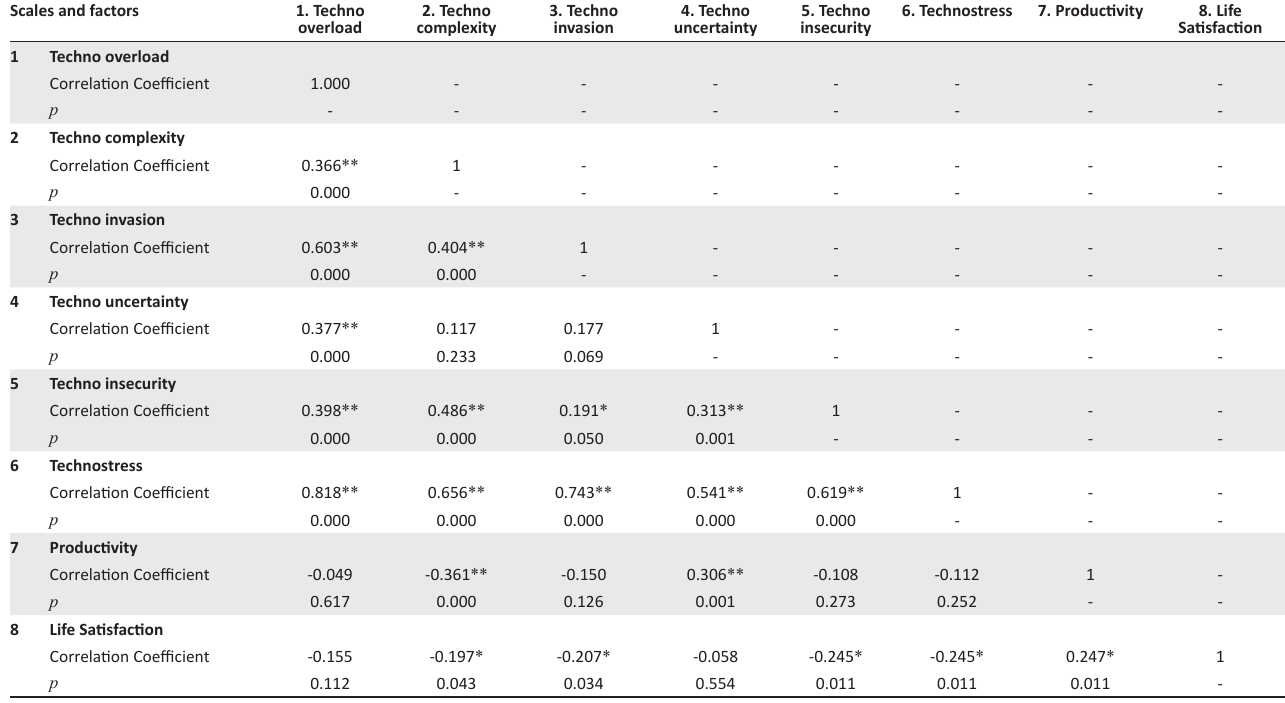
TABLE 6: Correlation between technostress, productivity and life satisfaction. Scales and